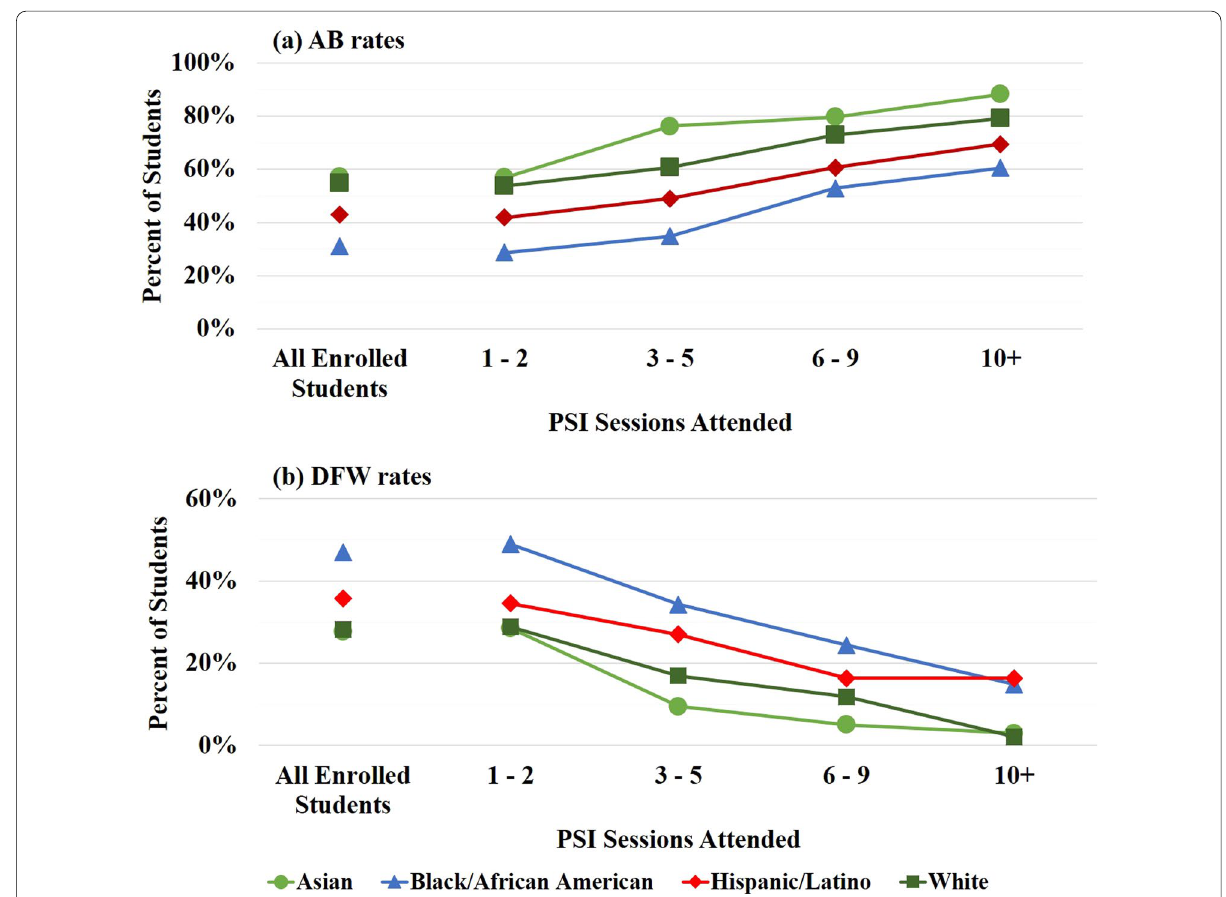
Fig. 4 Aggregated a AB and b DFW rates for PSI attendees as a function of PSI attendance and students’ identified race/ethnicity